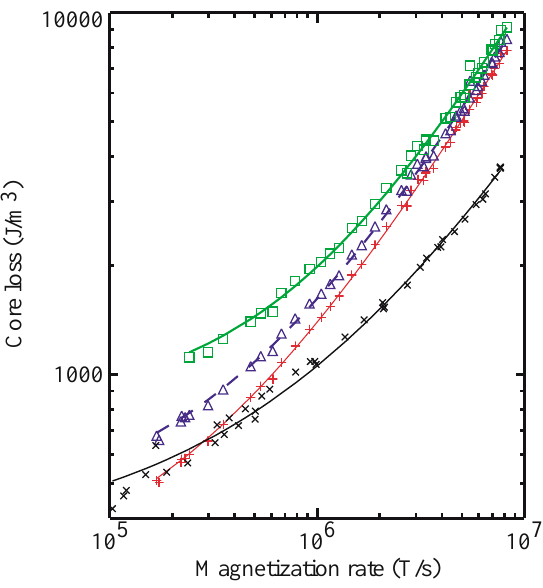
FIG. 25. (Color) Core loss versus magnetization rate comparing a 6% silicon steel core, at three flux swings, with a 25 m m thick 3% silicon steel core. The data are for the listed flux swings: ( (cid:1) , green, heavy line) Si6-3 at 2.60 T; ( (cid:3) , blue, dashed line) Si6-3 at 2.50 T; ( 1 , red, solid line) Si6-3 at 2.40 T; and ( 3 , black, solid line) 3301-1 at 3.00